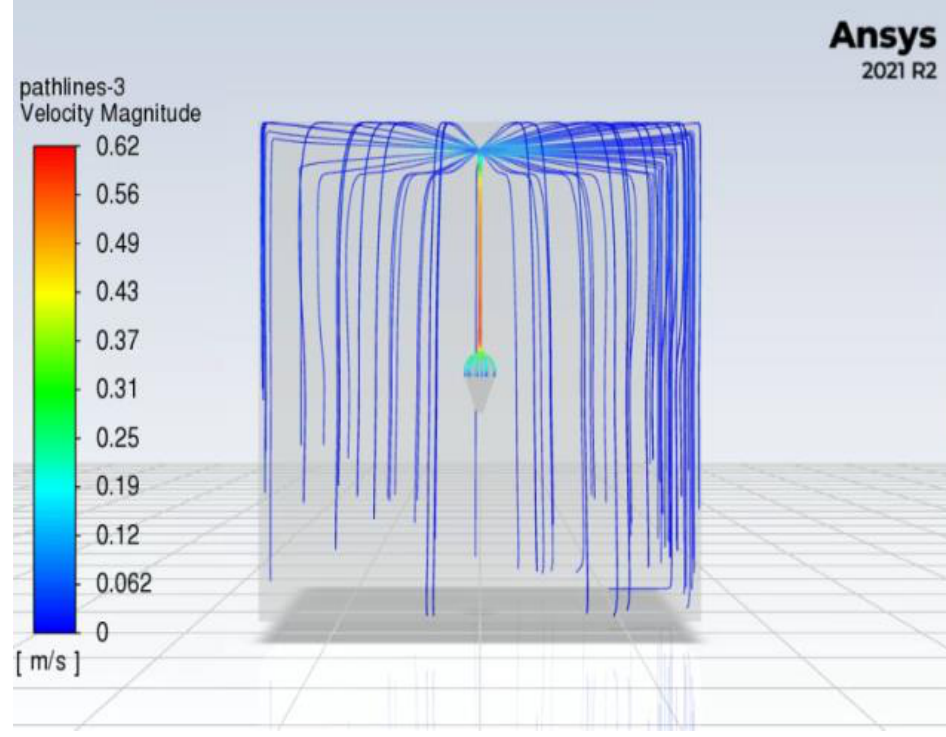
Figure 11. Air particle tracks, [m/s]. Table 2. Summary of temperature measurement results on the inner and outer walls of the “hot box” measuring